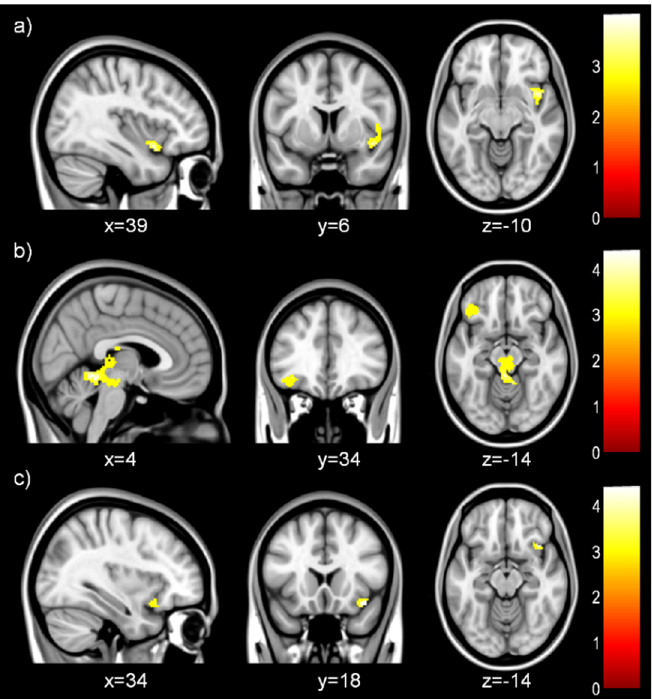
Fig 3. Neuroimaging Results. Between-group differences during negative emotion maintenance (Maintain/ Observe) in normal-weight versus excess-weight participants. An emotion generation mask (a) and a mask consisting of combined one-sample results (b) were used. Between-group differences during negative emotion reappraisal (Regulate/Maintain) in excess-weight versus normal-weight participants (c). An emotion generation mask consisting of the amygdala and insula was